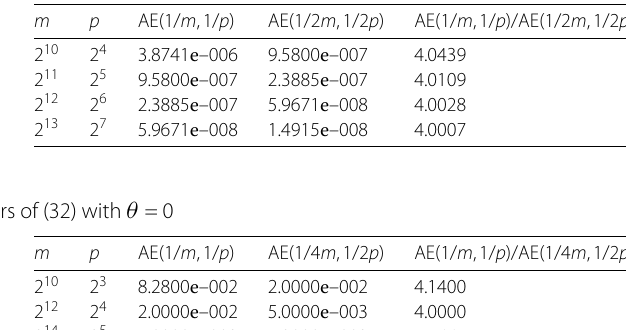
Table 2 Errors of (31) with θ = 1/2